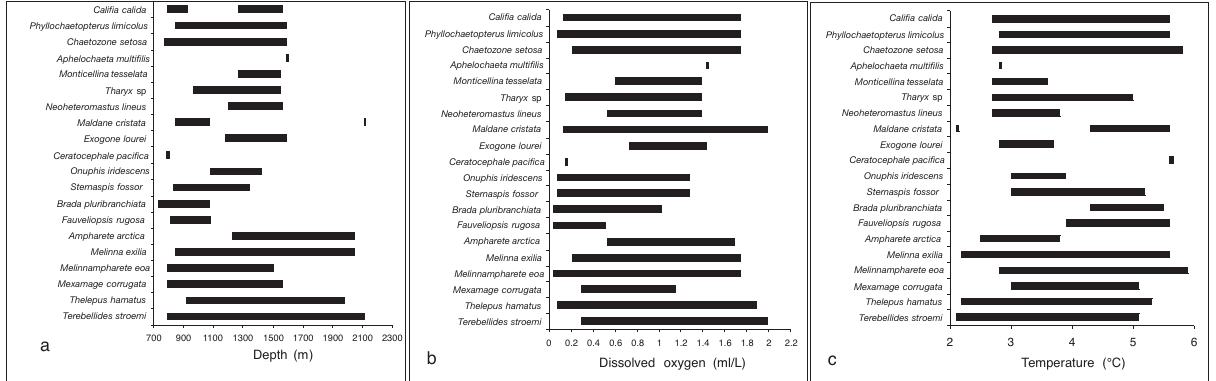
F IG . 8. – Depth (a), dissolved oxygen (b), and temperature (c) associated with the identified dominant and frequent species over the